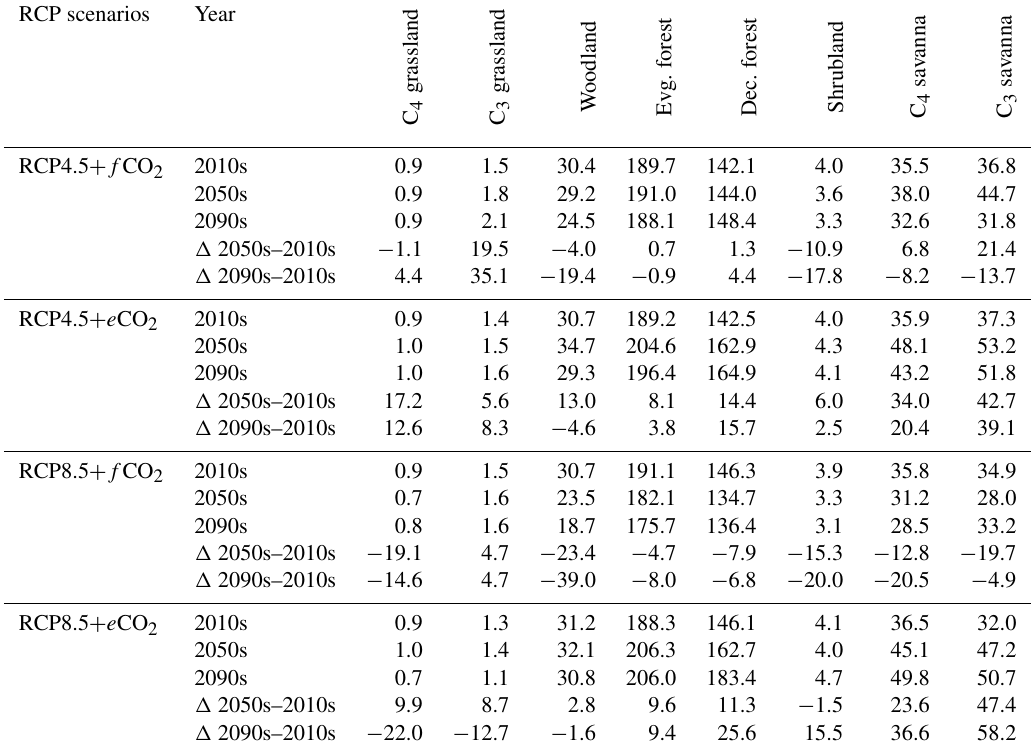
Table 2. Mean biomass (in t/ha) within biomes for the 2000s, 2050s and 2090s, and percent (%) change in biomass from the 2000s to the 2050s and the 2000s to the 2090s under RCP4.5 and RCP8.5 with fixed and elevated CO 2 . (cid:49) indicates percentual biomass changes between time